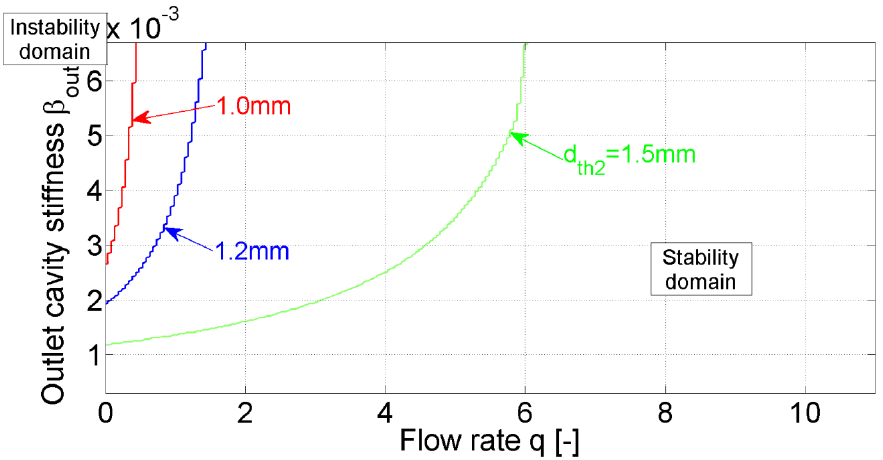
Figure 7. Stability domains at various diameter of throttle 10 for the constant values of leakage Q leak and area of throttle 11 A th 1 ( A th 1 = 1.77 mm 2 , Q leak = 16 l / min ).